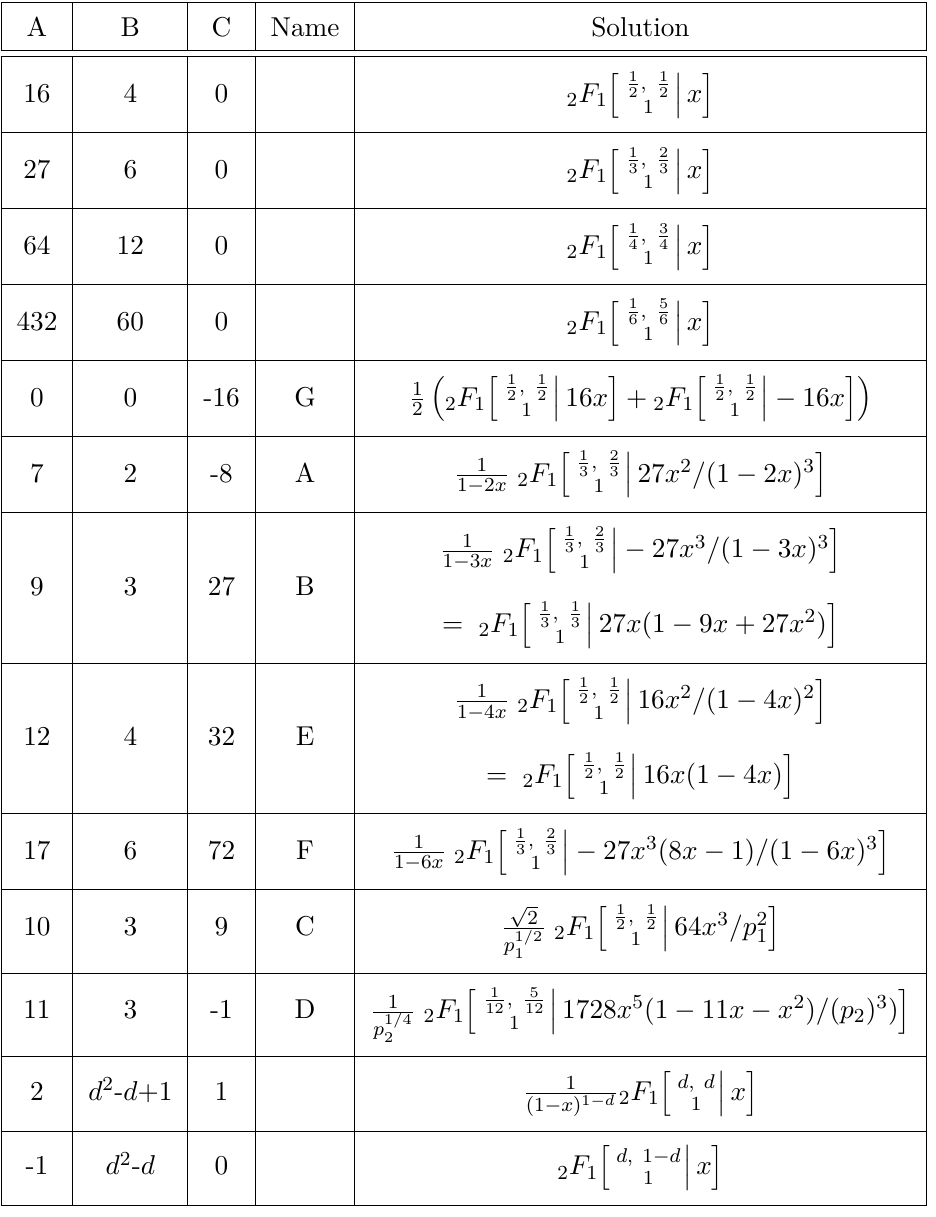
(cid:0) 1 ; 1; y (cid:1) function in case , 5 12 12